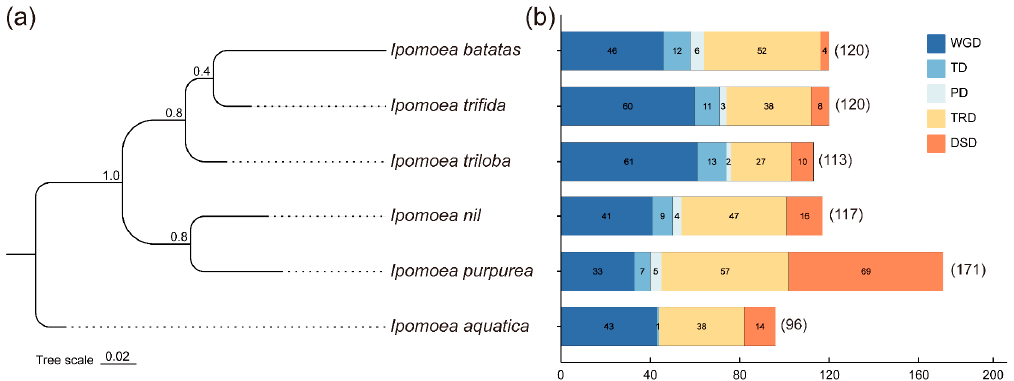
Figure 5. The number of R2R3-MYB gene pairs derived from different gene duplication events in the six Ipomoea species. ( a ) The phylogenetic relationship among the six Ipomoea species. The species tree was inferred from a concatenated alignment matrix of 9835 single-copy ortholog sequences across 6 Ipomoea species genomes. ( b ) The number of five models of duplicated gene pairs in each species. The gene duplication events include whole-genome duplication (WGD), tandem duplication (TD), proximal duplication (PD), transposed duplication (TRD), and dispersed duplication (DSD). The x-axis represents the number of duplicated gene pairs. The y-axis represents species. The non-synonymous substitution (Ka) to synonymous substitution (Ks) ratio